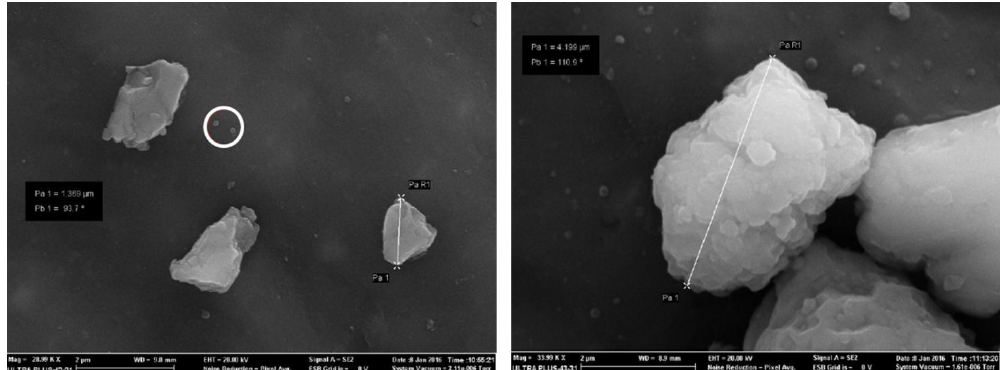
Figure 6. SEM analysis of the particles collected on 11 February 2015, during a drone launch exercise.